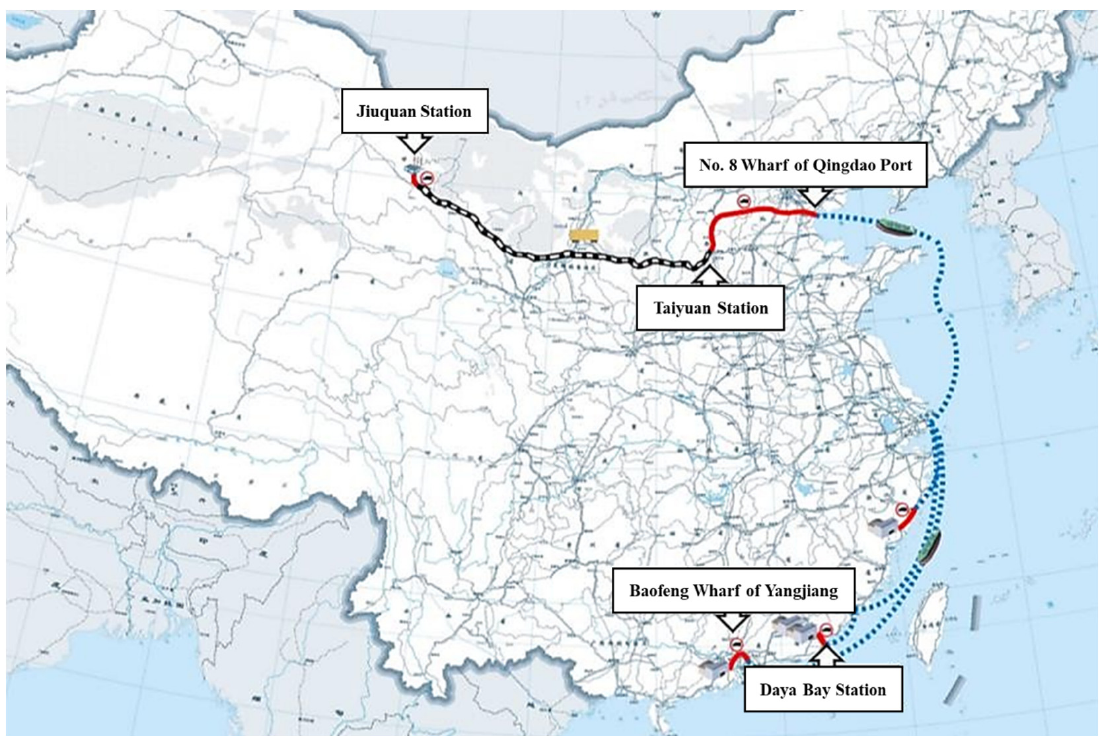
Figure 4. A numerical example of the joint path selection plan for transportation.